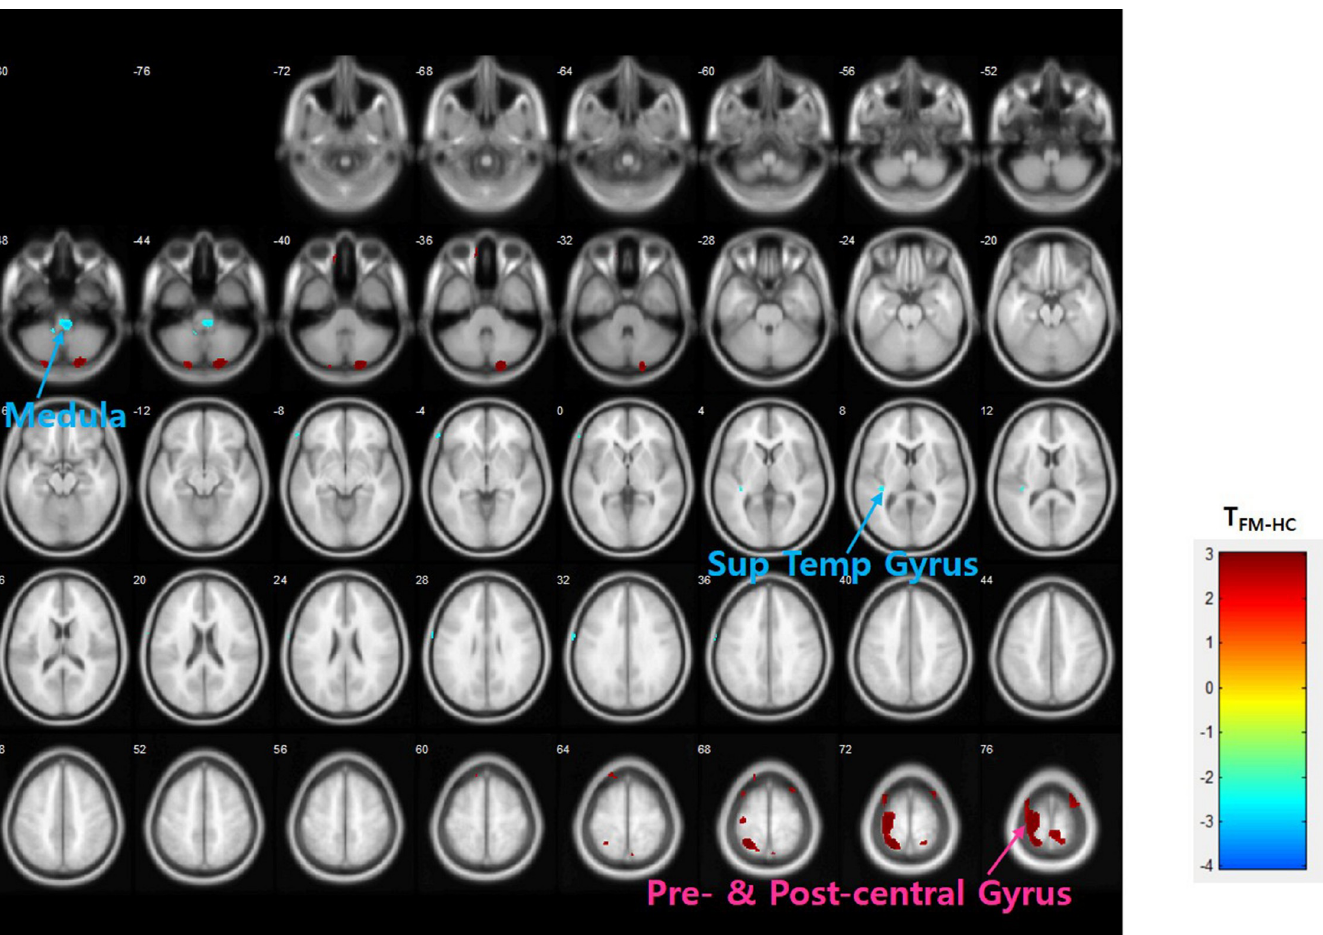
Fig 1. Differences in neuroinflammation indexed as DVR of [ 11 C]-(R)-PK11195 between FM and healthy controls. Analysis of covariance (ANCOVA) with gender covariate, uncorrected p < 0.01. https://doi.org/10.1371/journal.pone.0246152.g001 left superior, middle and medial frontal gyri (p < 0.01, p < 0.01, and p < 0.001, respectively), the left inferior and superior parietal gyri, the left precuneus (p < 0.01), the left caudate (p < 0.01), the right putamen (p < 0.01), and the right superior, middle, and medial frontal gyri (p < 0.005) (Fig 2). Additionally, using ROI analysis while controlling for the duration effect in the comparison of CRPS and healthy control groups, a higher [ 11 C]-(R)-PK11195 DVR was found in the in right insula (p = 0.033), left thalamus (p = 0.042), left precentral gyrus (p = 0.027), right and left postcentral (p = 0.018, p = 0.025, respectively), right and left middle frontal (p = 0.001, p = 0.004), right and left medial frontal (p = 0.009, p = 0.006), right and left superior frontal (p = 0.011, p = 0.010), left lateral orbitofrontal (p = 0.029), left superior parietal (p = 0.035), right and left caudate head (p = 0.014, p = 0.013), right and left nucleus accumbens (p = 0.007, p = 0.020), left putaman (p = 0.004), left caudate (p = 0.019), left globus pallidus (p = 0.050), and right superior marginal (p = 0.012) in CRPS patients. Differences in neuroinflammation between FM and CRPS patients Higher neuroinflammation levels in the left pre- and post-central gyri were found in the FM group compared with the CRPS group (p < 0.001 and p < 0.005, respectively) (Fig 3). On the